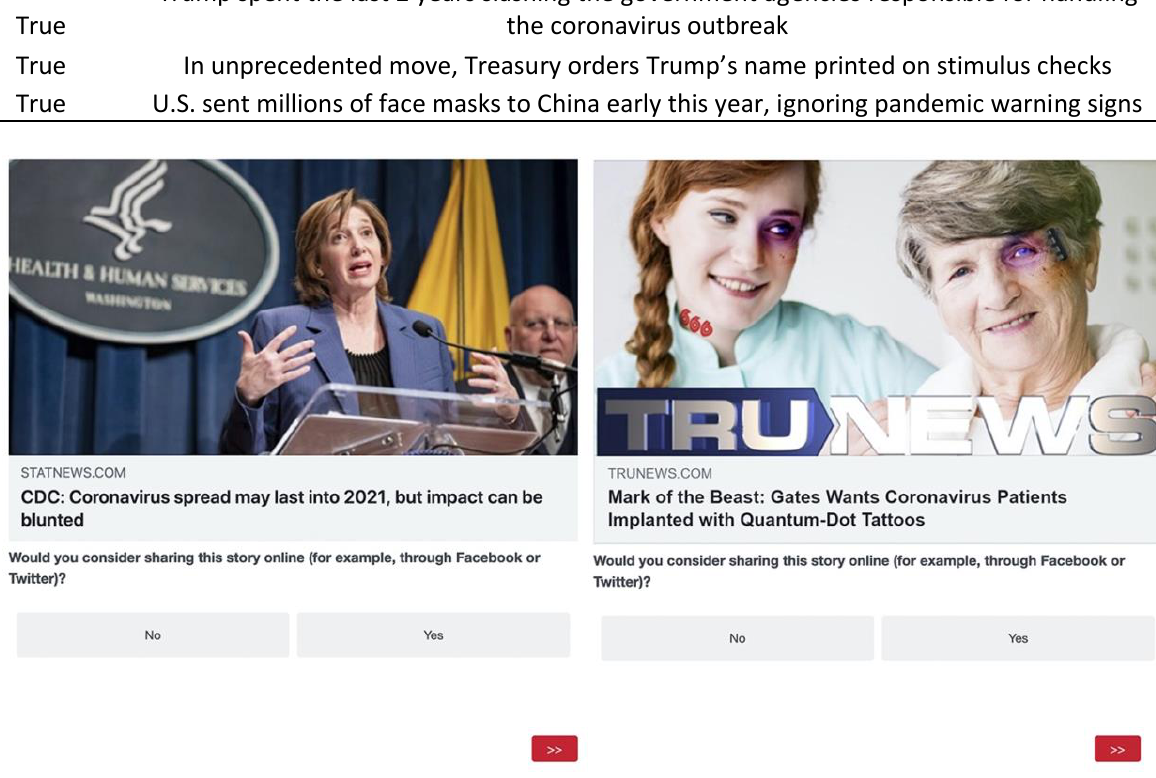
Figure 5. Sharing intentions input screen for a sample true (left) and false (right)